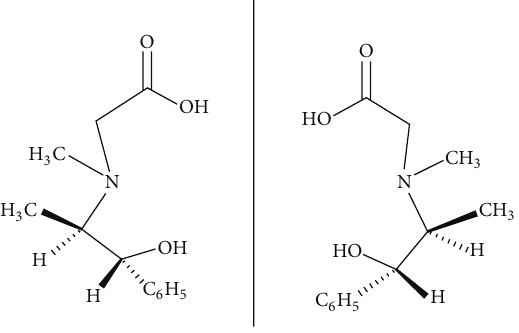
Figure 1: Structures for ( S,S (+)H 2